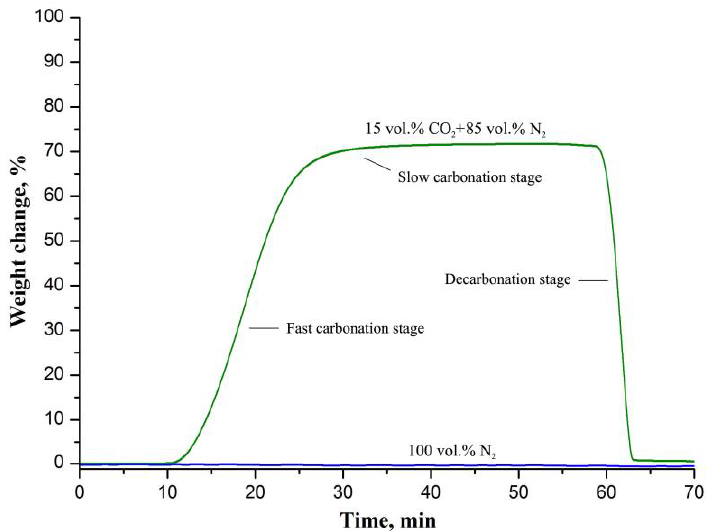
Figure 5. The carbonation–decarbonation cycle profiles of CaO nanofibers upon carbonation in the gaseous stream containing 15 vol.% CO 2 and 85 vol.% N 2 ; and in pure N 2 . During carbonation the mass of CaO nanofibers increases by 72.15 wt.% that corre- sponds to the CO 2 -uptake capacity of 16.4 mmol/g. The fabricated CaO nanofibers show a rather high capacity since the stoichiometric capacity of CaO is 17.9 mmol/g. The ob- served absence of a change in the weight of the sorbent upon carbonation in pure N 2 in- dicates that it does not sorb N 2 in the temperature range of 500 – 800 °C. The CO 2 -uptake capacity of CaO nanofibers is inferior to that of the nanosized powder CaO sorbent that was fabricated using flame-spray pyrolysis [10] and exceeds, for example, the capacity of nanosized powder CaO sorbents produced by the calcination method [28], the sol-gel technique [29] and mechanical milling [12]. The characteristics of synthetic CaO sorbents produced by various methods are presented in Table 1. Table 1. Comparison of synthetic CaO sorbents obtained by various methods. Method